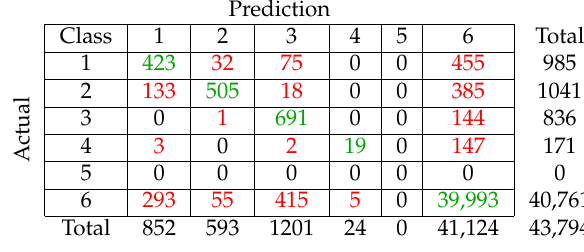
Table 8. Confusion matrix displaying results from the LSTM classifier. The green highlighted numbers are true positives, and the red highlighted numbers are false